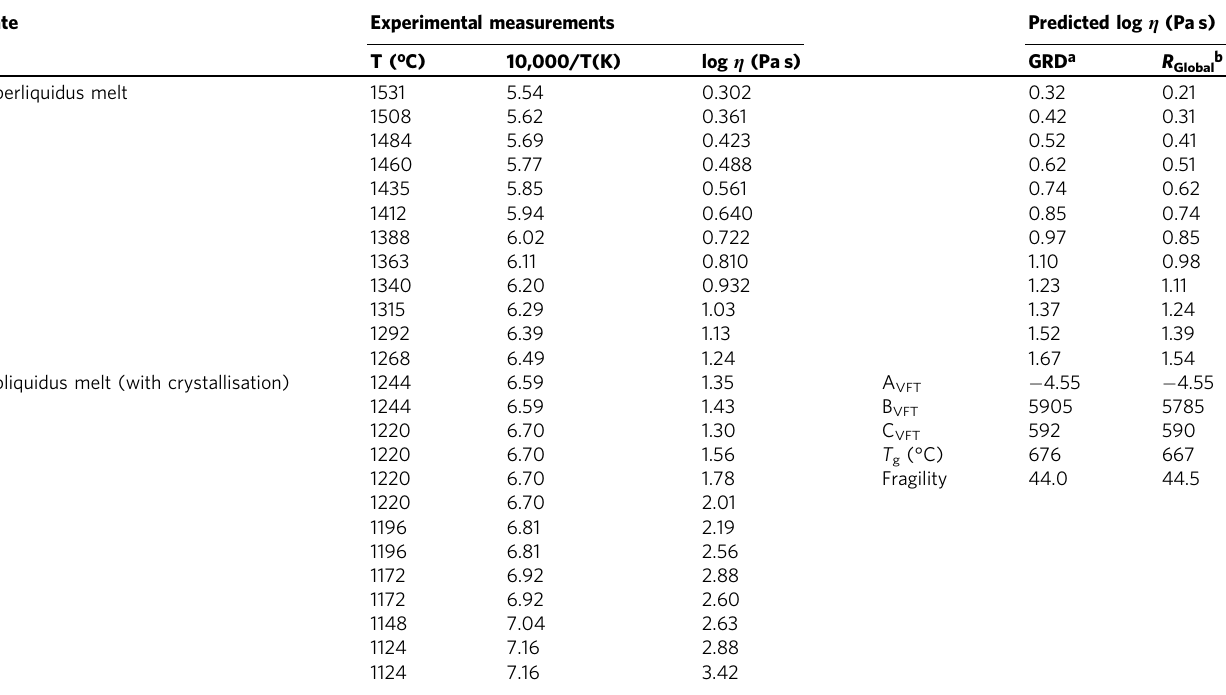
Table 1 Experimental measurements of viscosity of Tseax lava based on remelt of sample TS-S71 (see Table S1) compared to values predicted by VFT models (i.e., A VFT , B VFT , C VFT ) for temperature dependence of melt